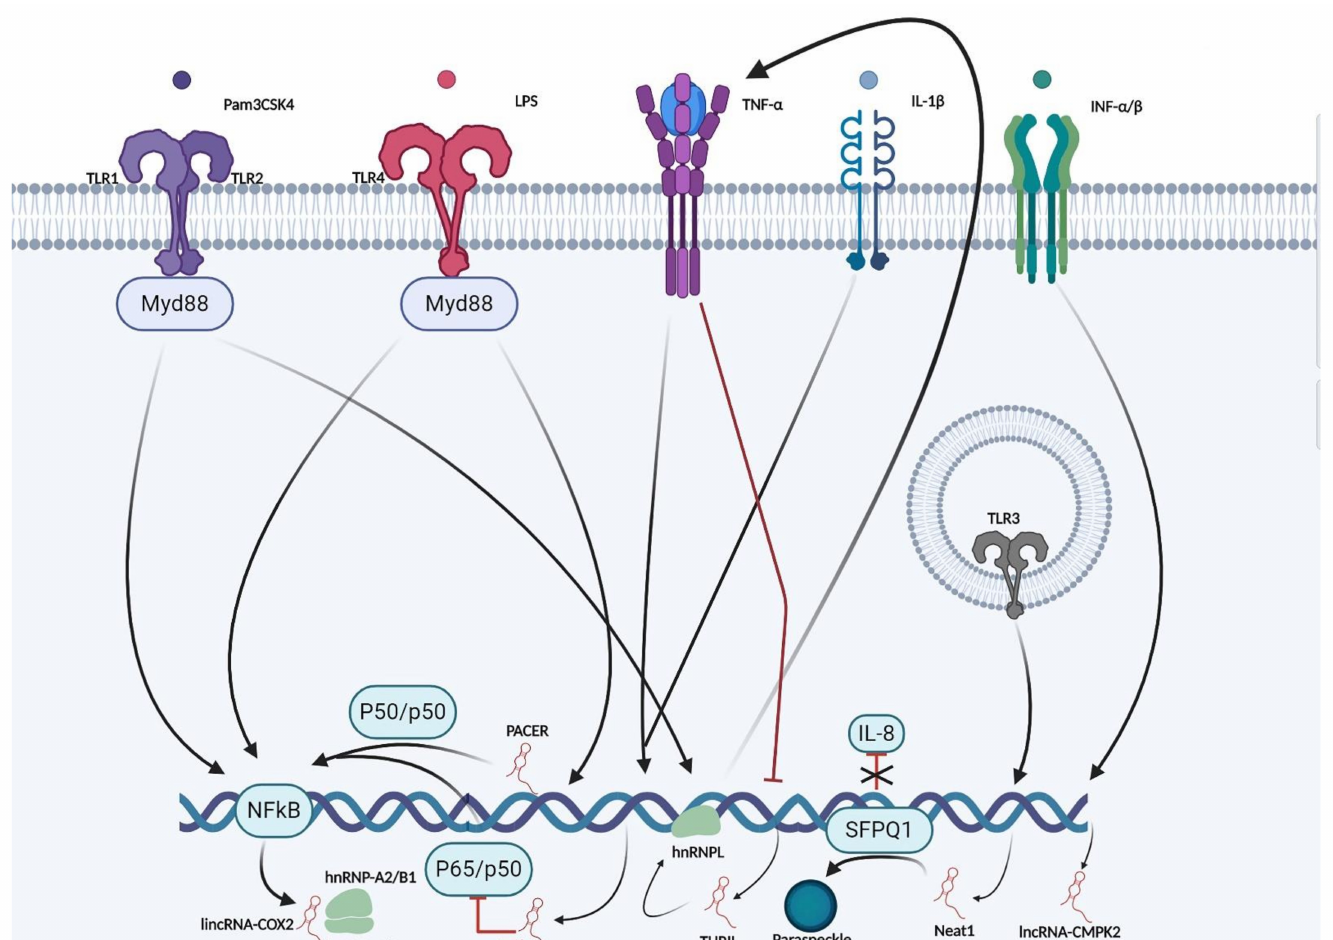
Figure 2. Examples of lncRNA roles correlated to immunity: a schematic summary about the most studied lncRNAs involved in DNA modulation discussed above. Normal arrows represent an interaction while red ones an inhibition. IL: Interlukin, hnRNP: Heterogeneous nuclear ribonucleoproteins.